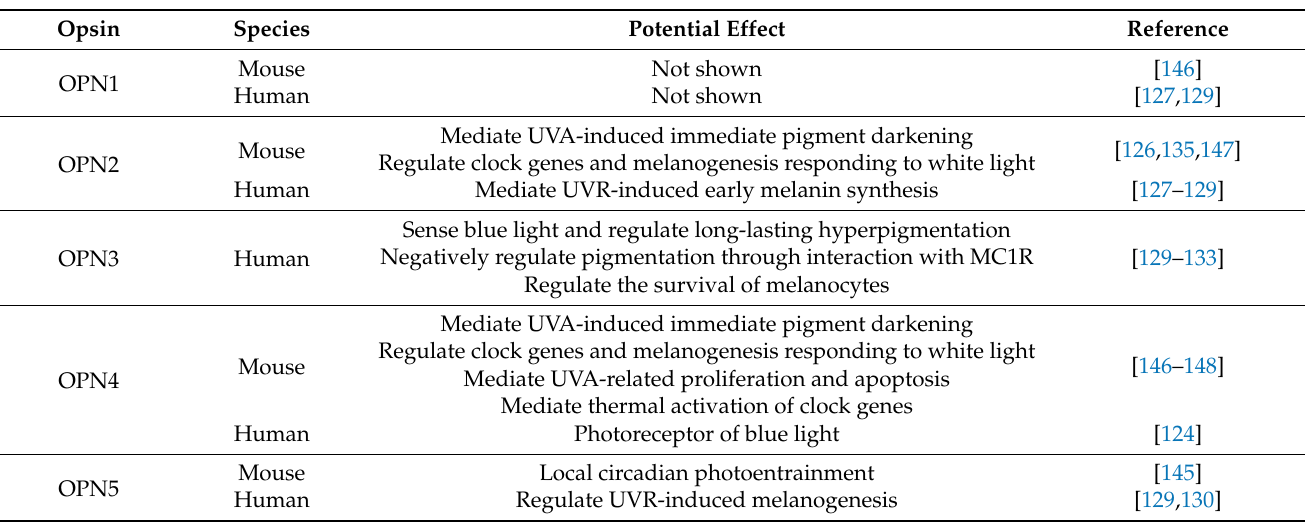
Table 1. Expression and Function of Opsins in